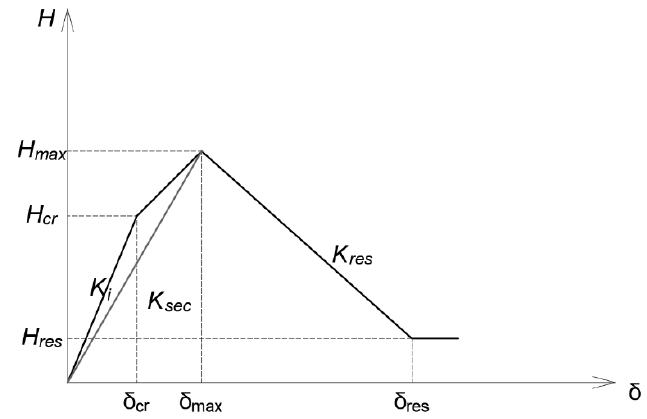
Figure 6. Infill panels backbone curve adapted from Decanini et al. [50,51].